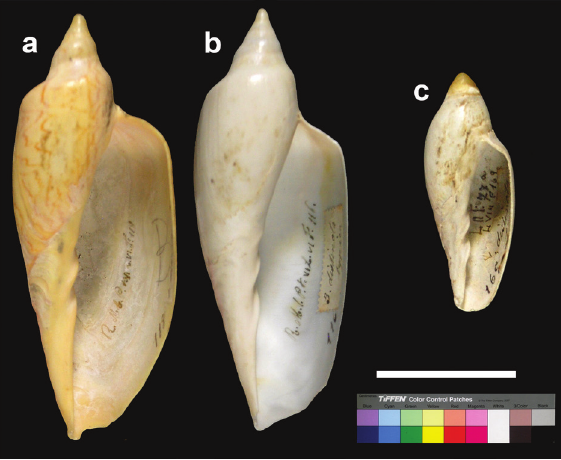
Figure 19. Voluta angulata distincta , specimens figured by La - hille (1895). See references on Table 6. Scale bar: 5 cm.